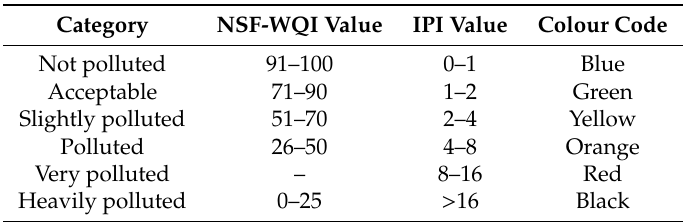
Table 4. Categorisation of surface water quality according to the National Sanitation Foundation